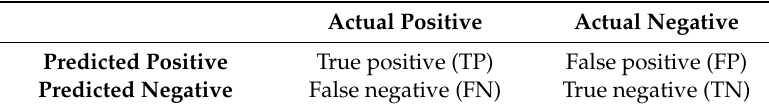
Table 3. Structure of the confusion